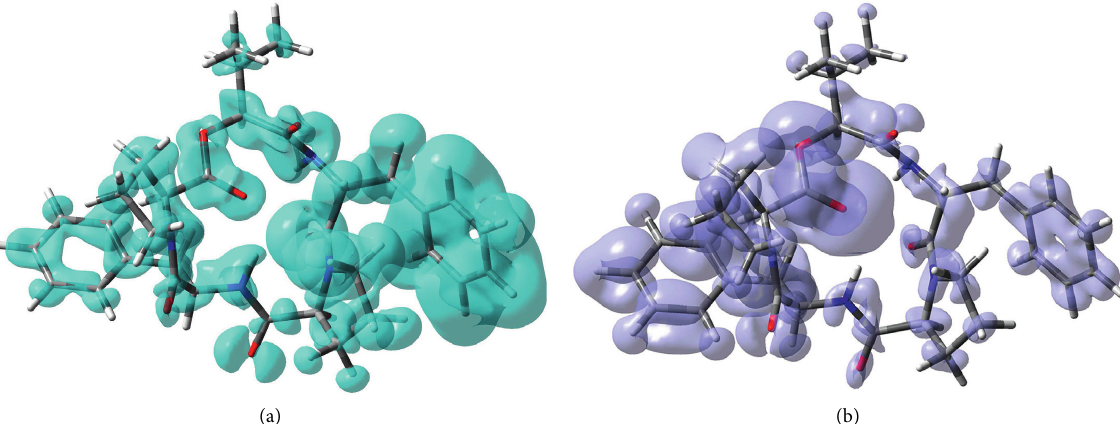
Figure 4: Graphical representation of the dual descriptor (DD) of the alternaramide marine cyclopentadepsipeptide. (a) DD > 0. (b) DD < 0.